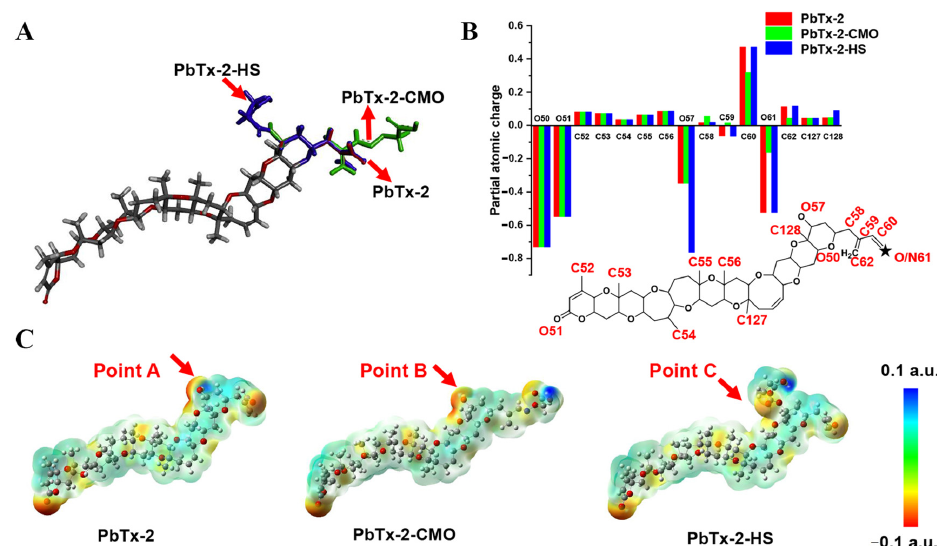
Figure 3. Molecular modeling results. ( A ) Overlap of PbTx-2 (gray), PbTx-2-CMO (green), and PbTx-2-HS (violet) structures. ( B ) Calculated partial atomic charges of PbTx-2, PbTx-2-CMO, and PbTx-2-HS structures. ( C ) ESP for PbTx-2, PbTx-2-CMO, and PbTx-2-HS structures. Red and blue areas indicate negative and positive potentials, respectively.